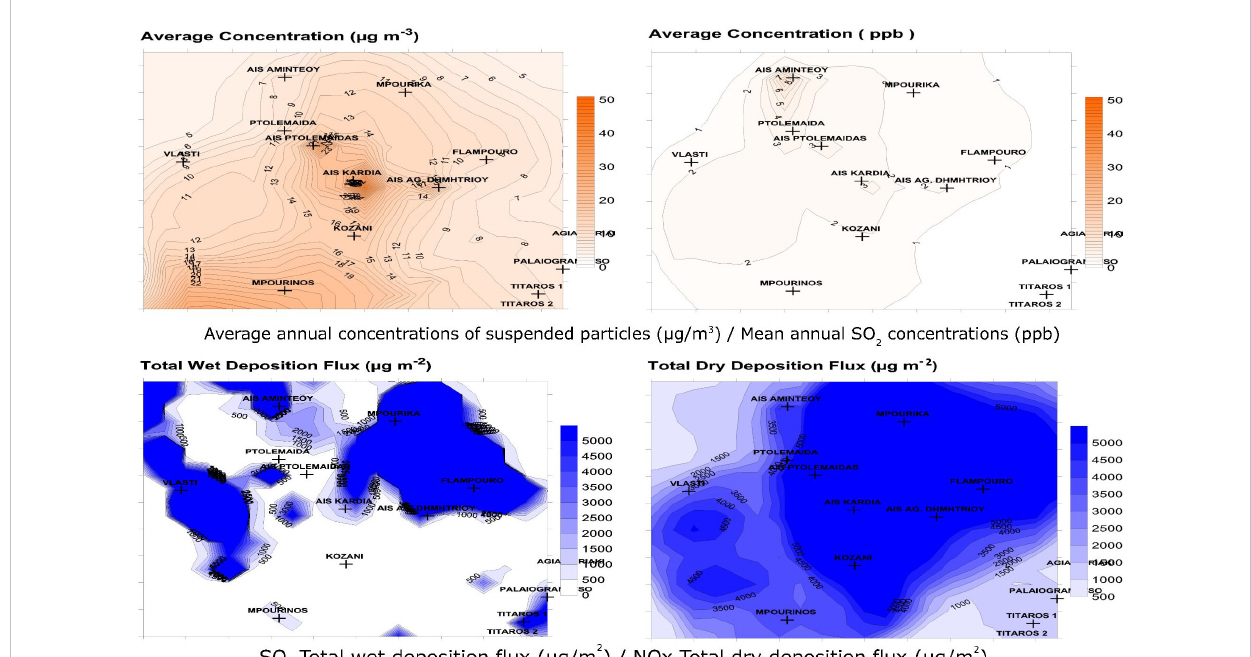
FIGURE 1 Mean annual PM10 concentrations, Mean annual SO2 concentrations, Total SO2 wet deposition fl ux, Total NOx dry deposition fl ux, based on the prognostic air pollution model (TAPM) in the in the Amyntaio-Ptolemaida-Kozani basin (APKB), region of Western Macedonia,